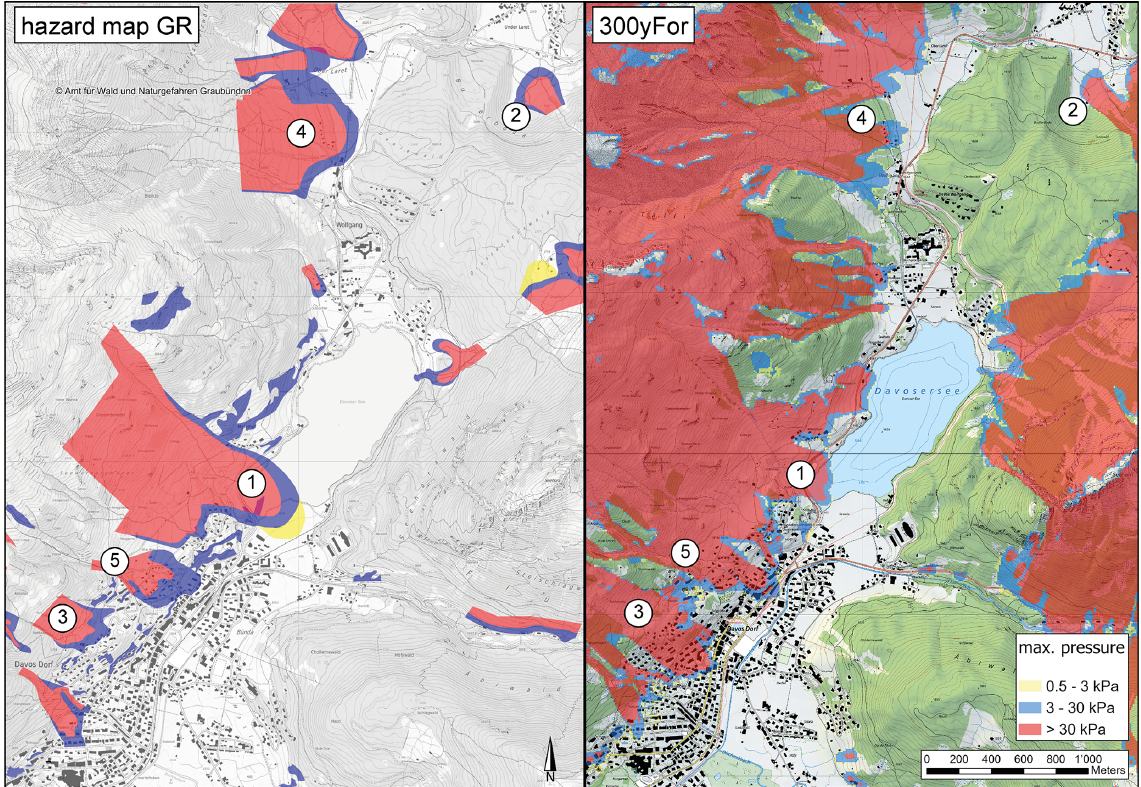
Figure 10. Comparison of the official hazard map (https://edit.geo.gr.ch/theme/Naturgefahrenkarte, last access: 23 May 2022; left) with the simulation results of the scenario 300yFor (right). The numbers indicate the location of selected avalanche tracks discussed in this section (map source: Swiss Federal Office of Topography).